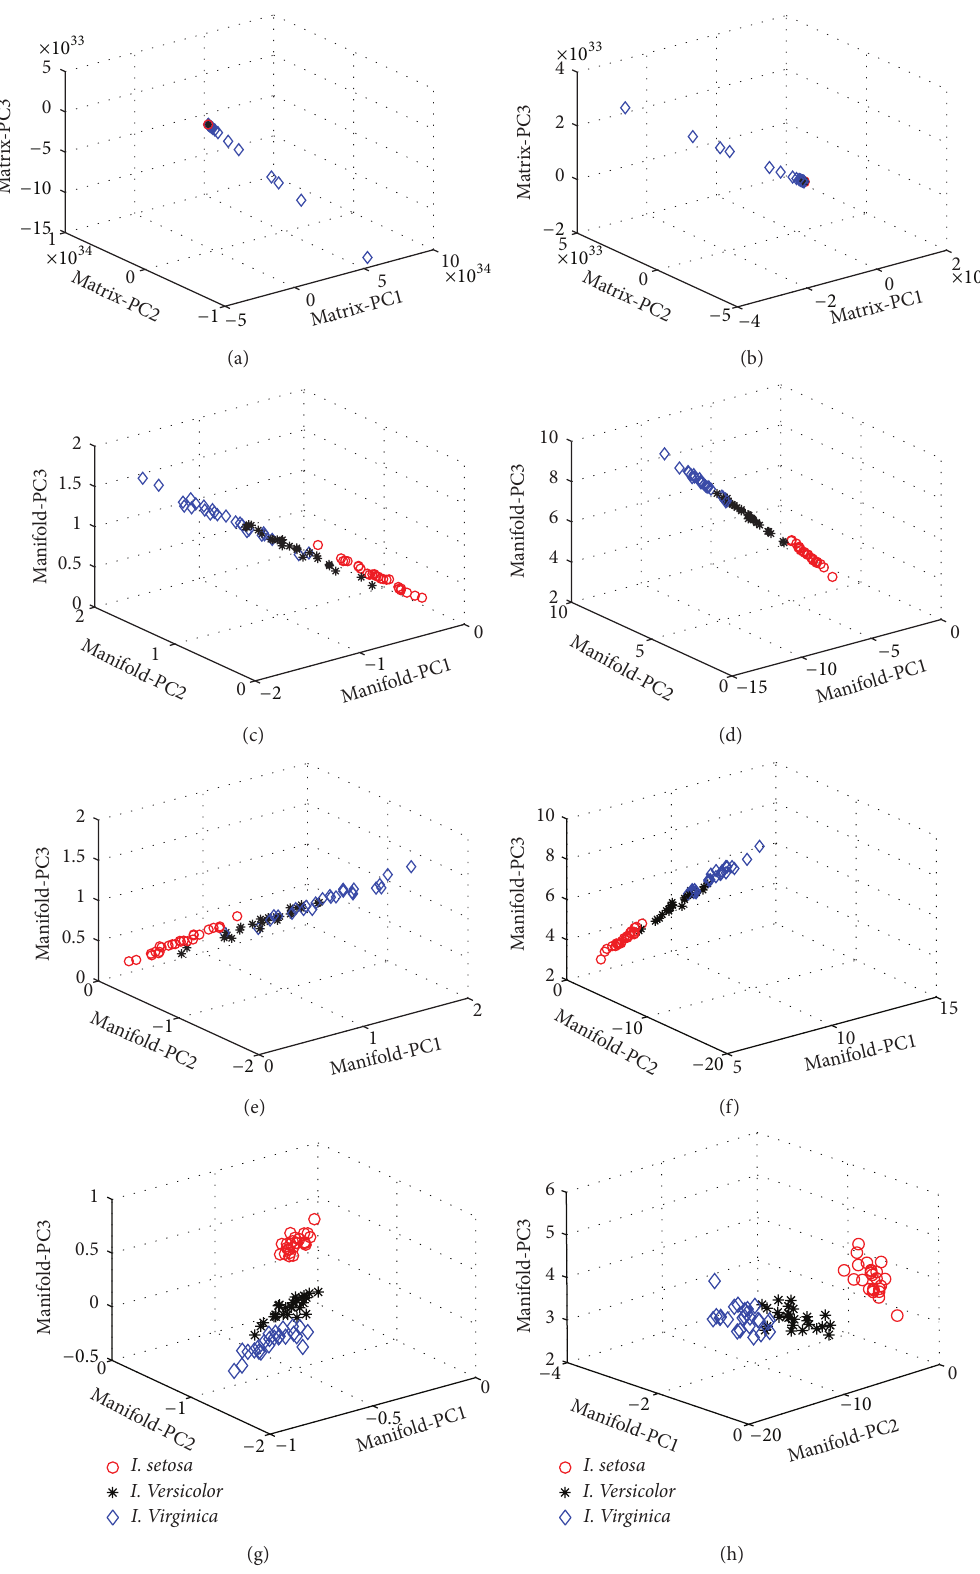
Figure 2: Scatter plots of iris dataset by different features: (a) KPCA Matrix feature of dataset1, (b) KPCA Matrix feature of dataset2, (c) NPP Manifold feature of dataset1, (d) NPP Manifold feature of dataset2, (e) LLD Manifold feature of dataset1, (f) LLD Manifold feature of dataset2, (g) KLLD Manifold feature of dataset1, and (h) KLLD Manifold feature of